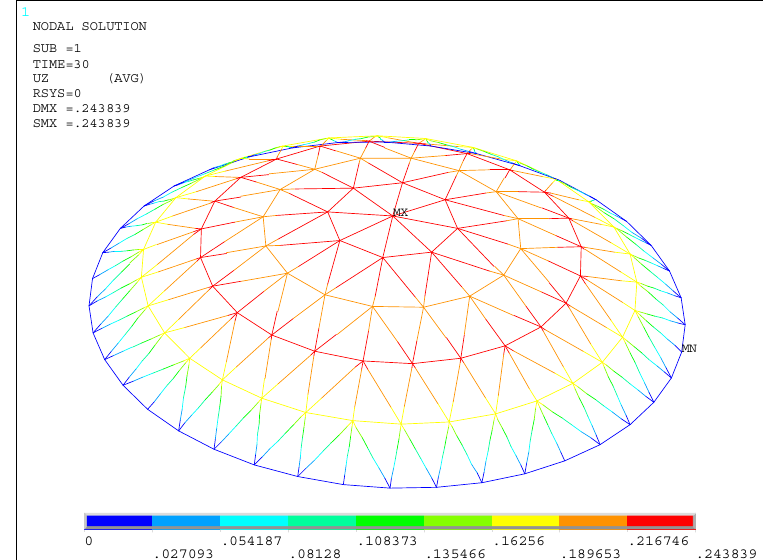
Figure 3. FE model of latticed shell structure.